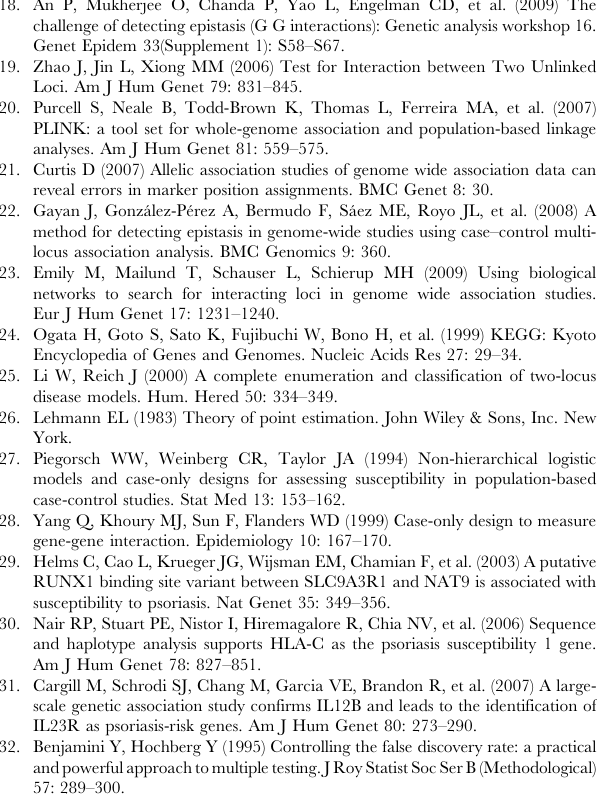
Table S2 A total of 211 pairs of interacted SNPs with FDR less than 0.003 in at two studies.